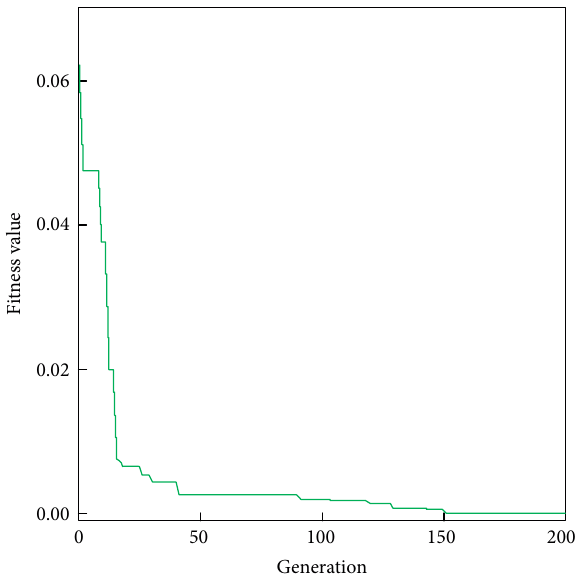
Figure 6: Evolution of fitness value for optimizing ANN-GA model.